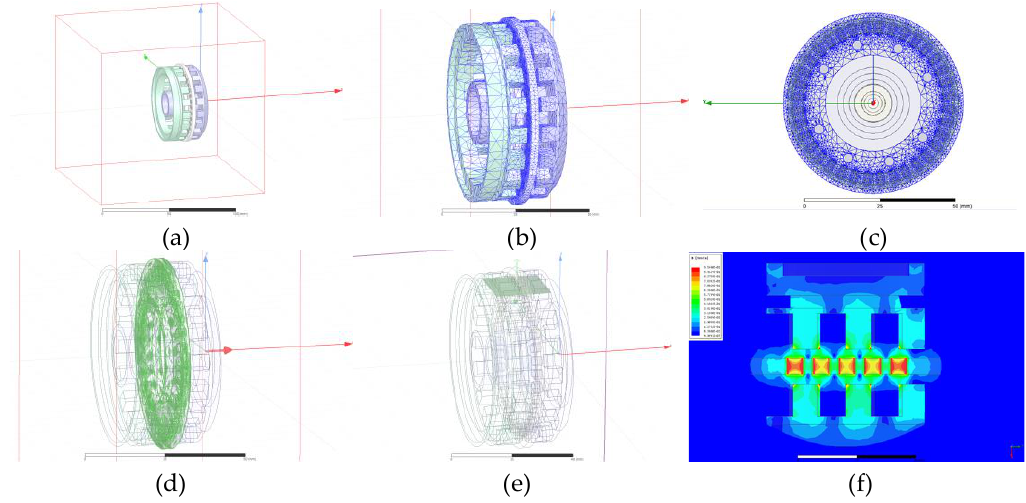
Figure 9. Finite element analysis of self-lock torque.: ( a ) Finite element model; ( b ) Mesh generation; ( c ) Directional view of meshing; ( d ) Analysis of self-lock torque; ( e )Select cross section to observe magnetic field distribution; ( f ) Local view of magnetic field.